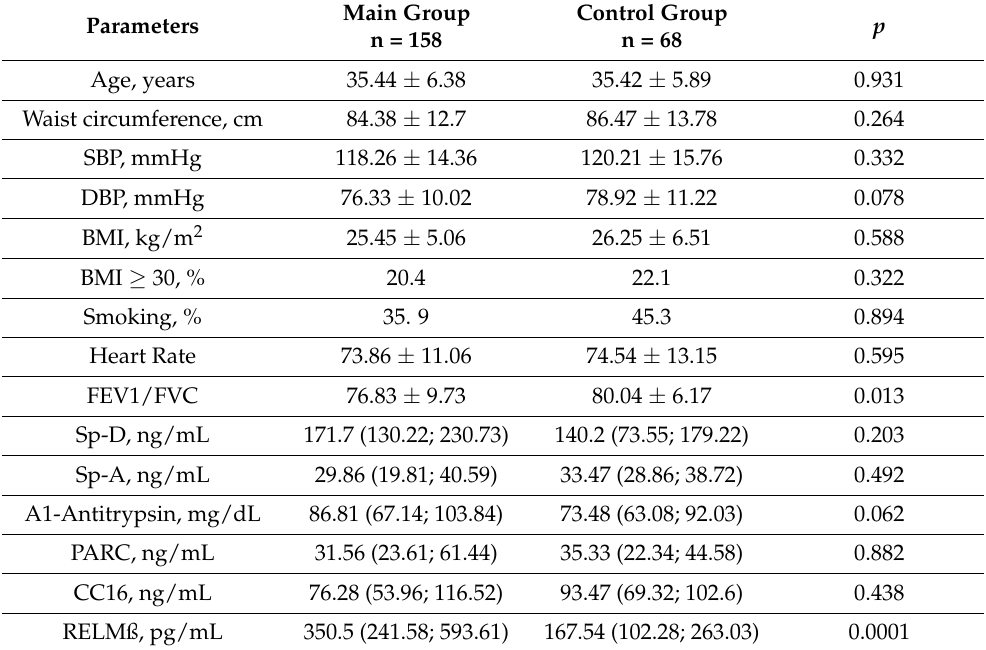
Main Group Control Group n = 158 n = 68